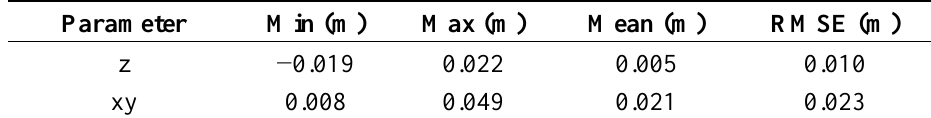
Table 3. The z- and xy-accuracies of the BoMMS point cloud compared to 16 reference sphere